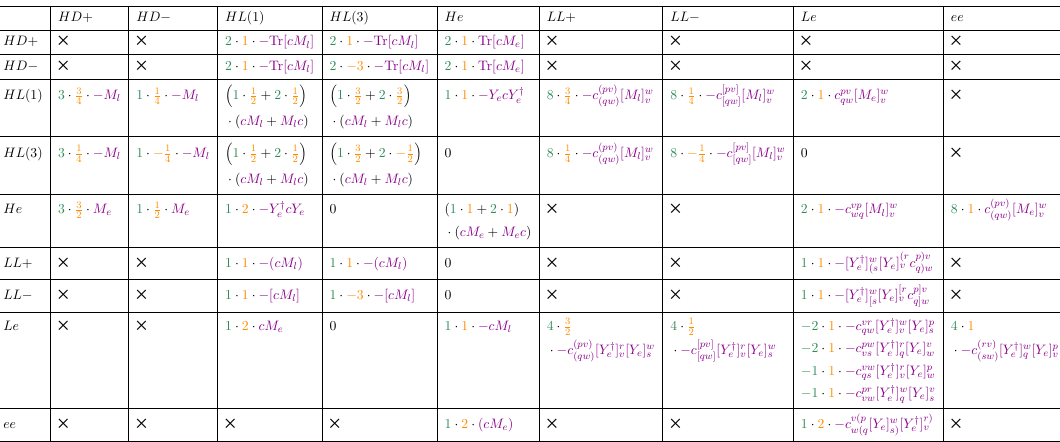
Table 6 . IR finite Yukawa pieces of the (4 , 0) block of the colourless SMEFT anomalous dimension matrix. We define M = Y † , M e = Y † Y e , . Operators are defined in table 11. Phase space factors, l e Y e e in green, can be found in appendix E.1 and are explained in section 3.1.1. Gauge factors, in